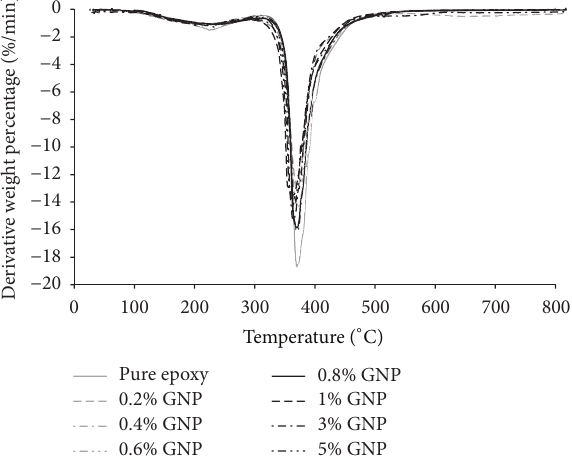
of GNP into epoxy resin has shown improvement on the flexural strength and modulus, as well as fracture toughness as compared to pure epoxy, where 0.4 vol.% achieved highest improvement on the overall mechanical performance.